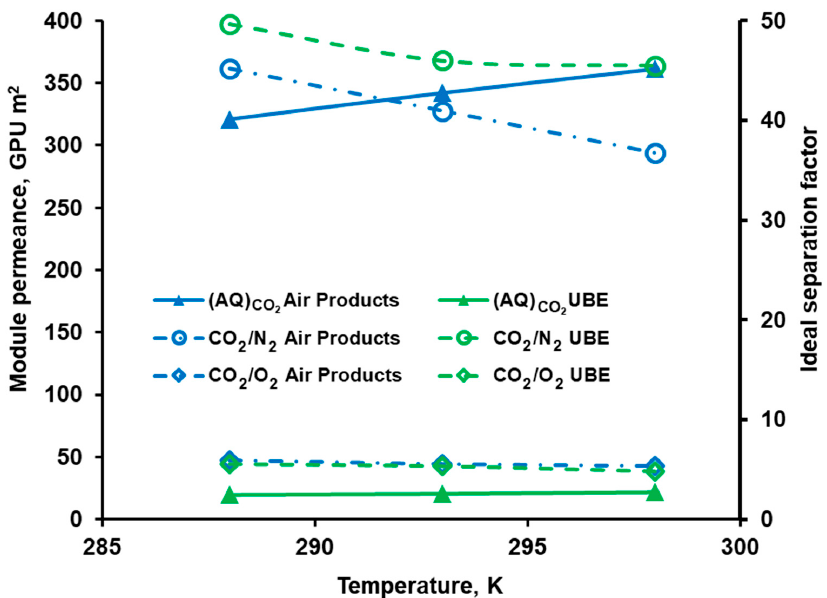
Figure 4. Module permeance of CO 2 and ideal selectivity of CO 2 /N 2 and CO 2 /O 2 in UBE UMS-A5 and Air Products PRISM PA1020 module against temperature. Air Products PRISM PA1020 module against